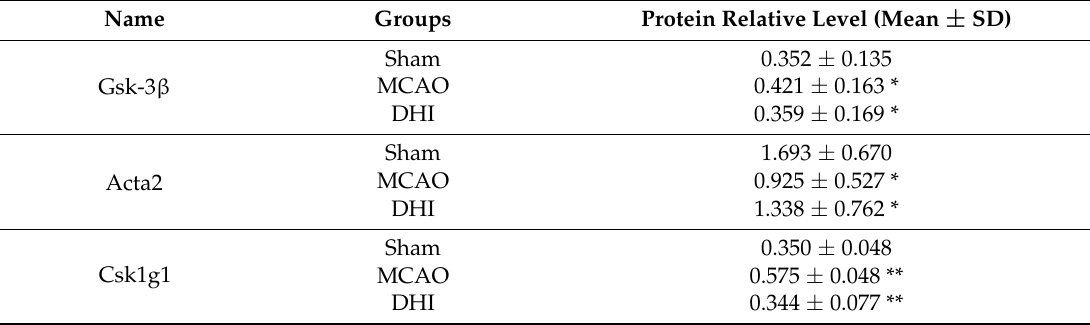
Figure 5. Selection and validation of the six candidates from the AMPK signaling pathway and the MAPK signaling pathway for the hippocampus after cerebral ischemic injury and repair by Western blot. The results of Western blotting of the six differentially displayed hippocampus proteome proteins were analyzed with a statistical method (one way ANOVA and multiple testing) by SPSS (Table 3). We show the trends of protein abundance, either from Western blotting or from the label-free analysis. Table 3. The quantity results of Western blot by quantity one software (* P < 0.05, ** P < 0.01).